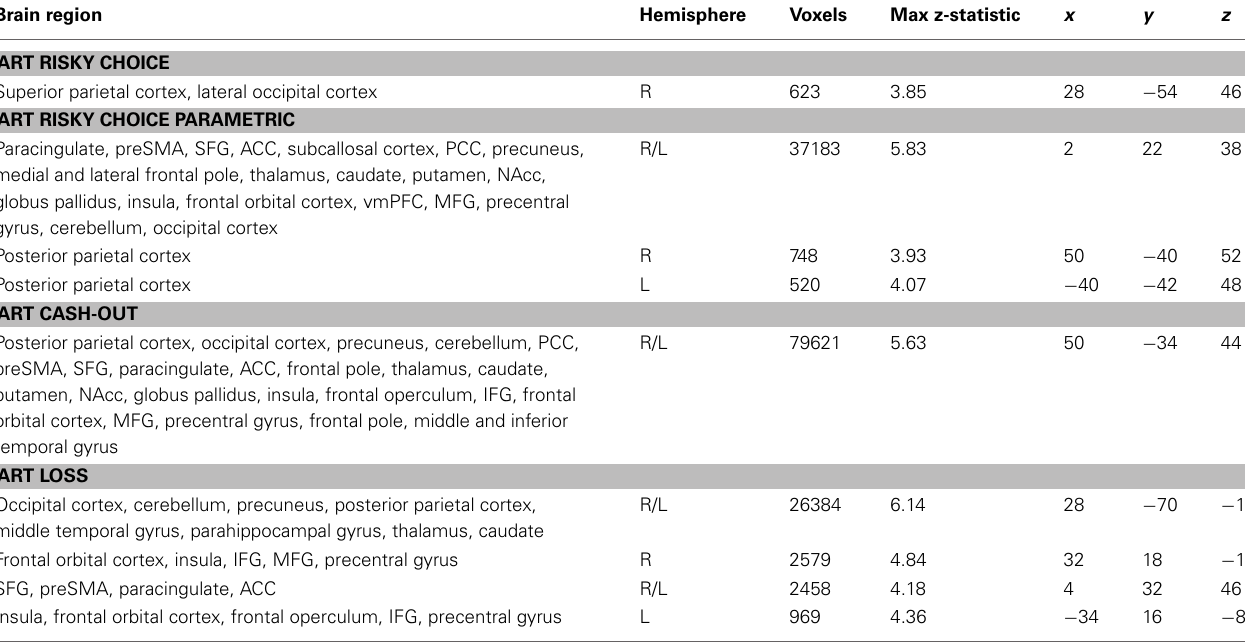
Table 2 | ART group contrasts.